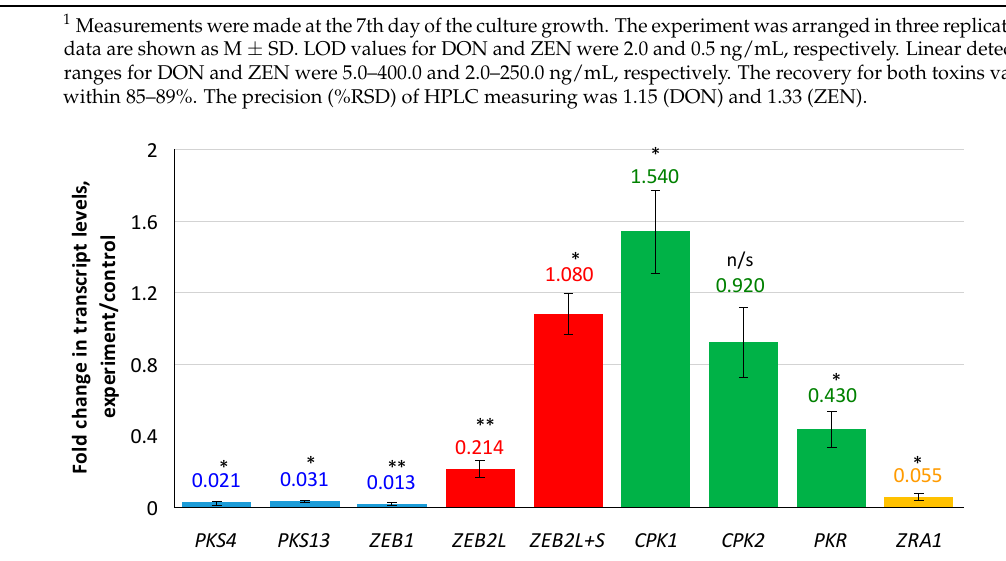
Figure 1. Effect of compactin on the relative expression of genes responsible for ZEN biosynthesis and regulation. The expression level (EL) for the untreated control was considered as 1.0; EL above or below 1.0 means up- or down-regulation, respectively. Blue bars indicate genes encoding biosynthetic enzymes; red bars indicate transcripts of a regulatory ZEB2 gene; yellow bar indicates a ZRA1 gene encoding the transport protein; green bars indicate genes encoding cAMP-dependent protein kinase subunits. Each bar is shown as M ± SD; n/s, no significant changes; * p < 0.05; ** p <